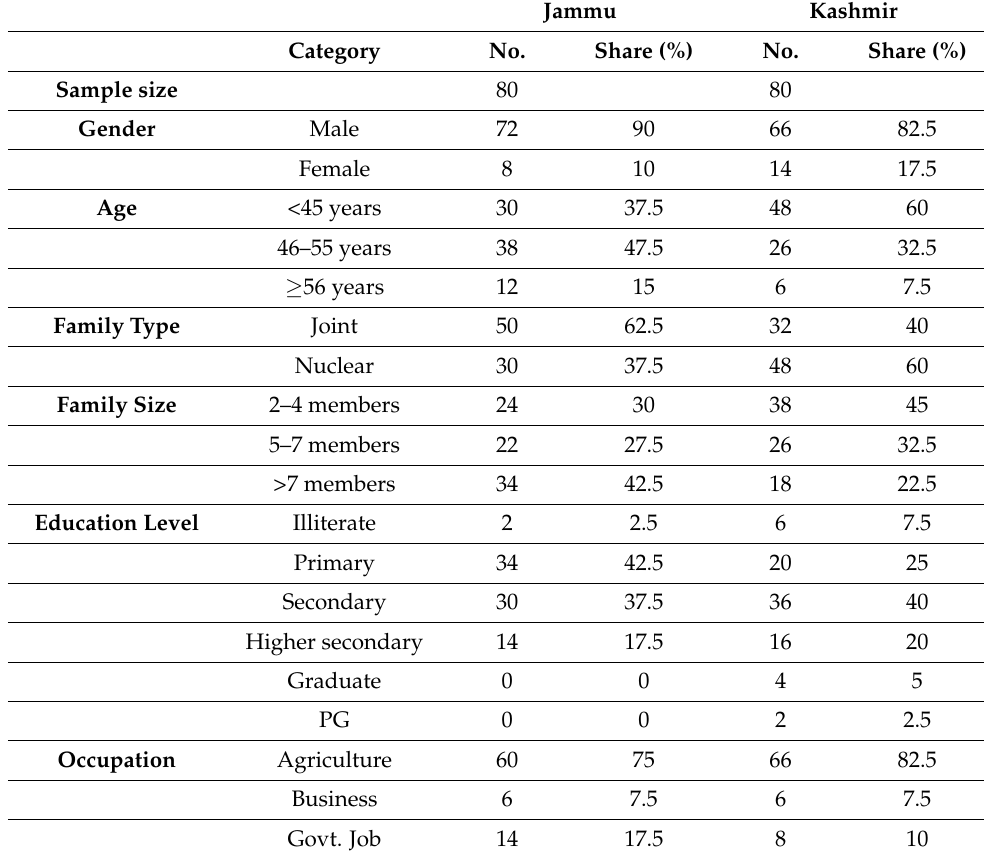
Table 1. Characteristics of sample farm